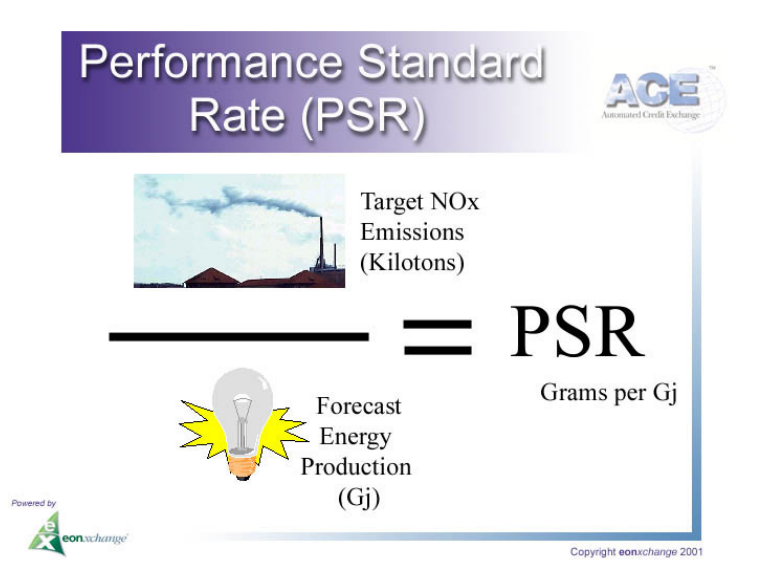
FIGURE 1. Performance standard